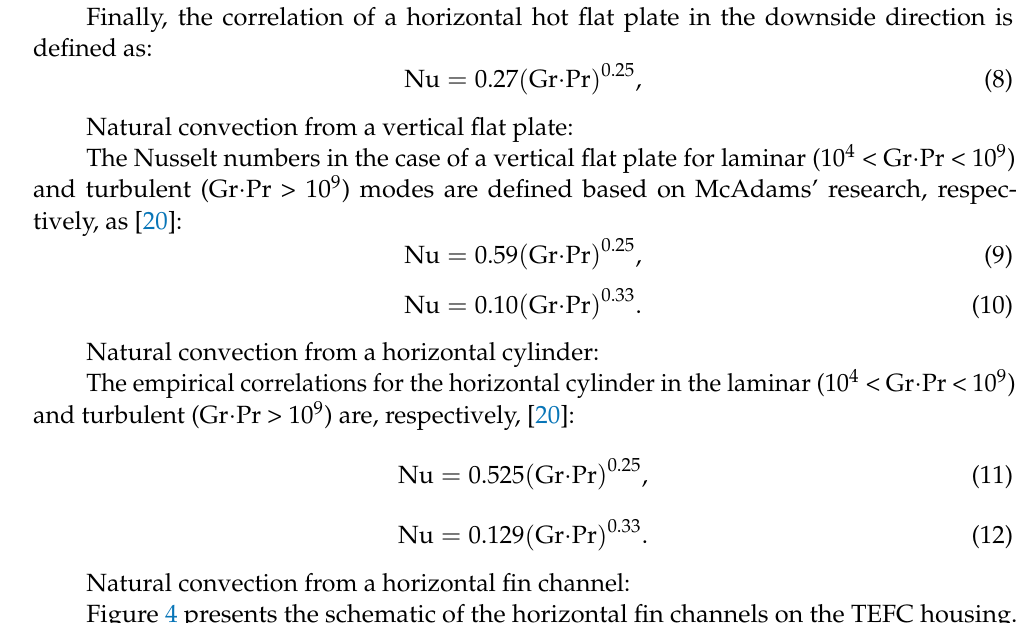
Figure 3. Two placements of a horizontal hot plate, ( a ) facing up, and ( b ) facing